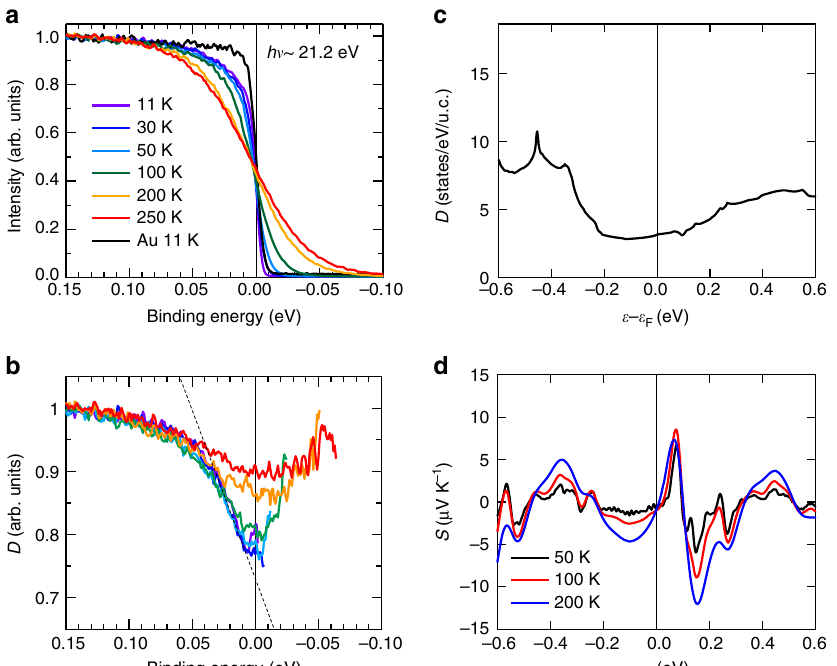
Fig. 2 Electronic structure for MnGe. a Temperature dependence of photoemission spectra for MnGe with the reference spectrum of Au. b Effective density of states obtained by dividing the photoemission spectra by resolution-convoluted Fermi distribution function. Here the narrow pseudogap (~40 meV) is discernible especially below the transition temperature. The dashed line is a fi tted linear function used for the estimation of thermopower. c Calculated density of states ( D ) of MnGe per unit cell (u.c.) assuming ferromagnetic state. d Seebeck coef fi cient calculated on the basis of the corresponding band structure in ferromagnetic state, which is far short of the experimental value. Vertical thin lines indicate the position of Fermi